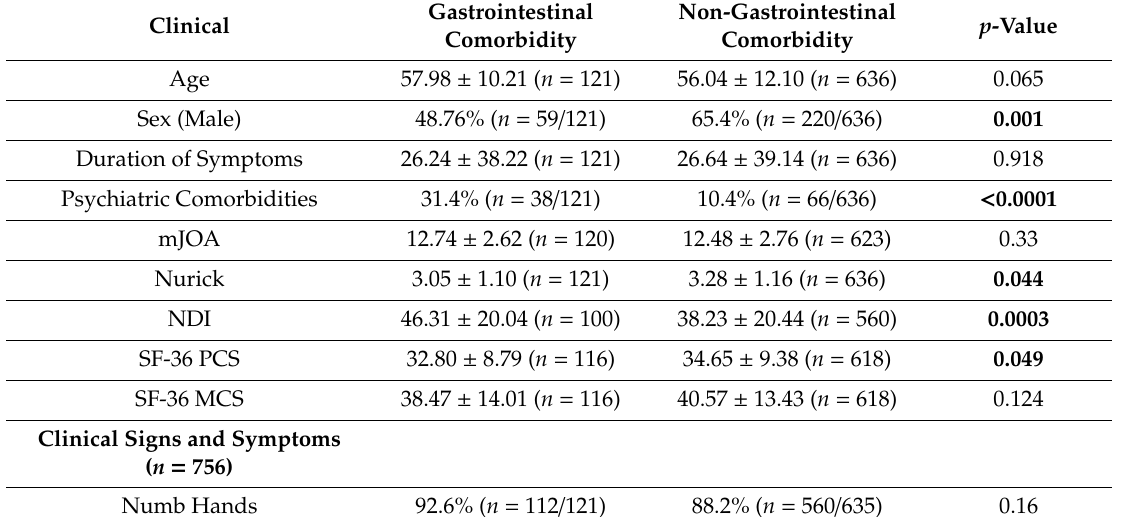
Table 1. Patient demographics and clinical and MRI